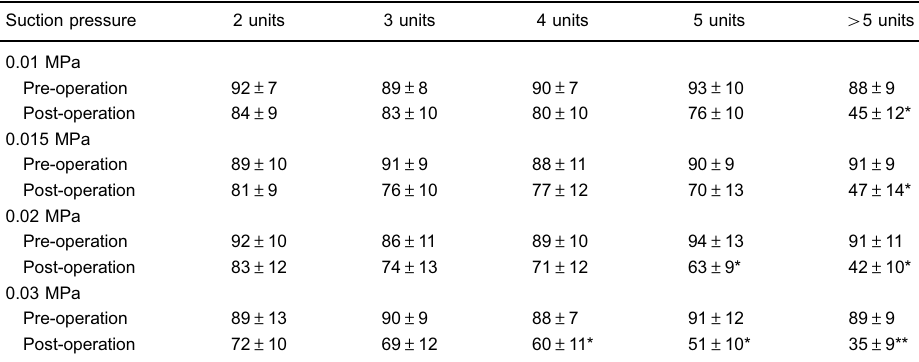
Table 4. Creatinine clearance (mL (cid:1) min – 1 (cid:1) (1.73 m 2 ) – 1 ) in pre-operative and 24 h post-operative patients.